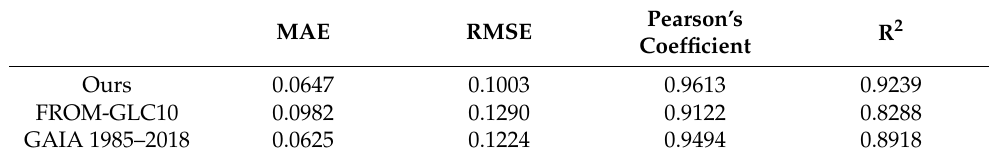
Table 2. Accuracy assessment of different models.